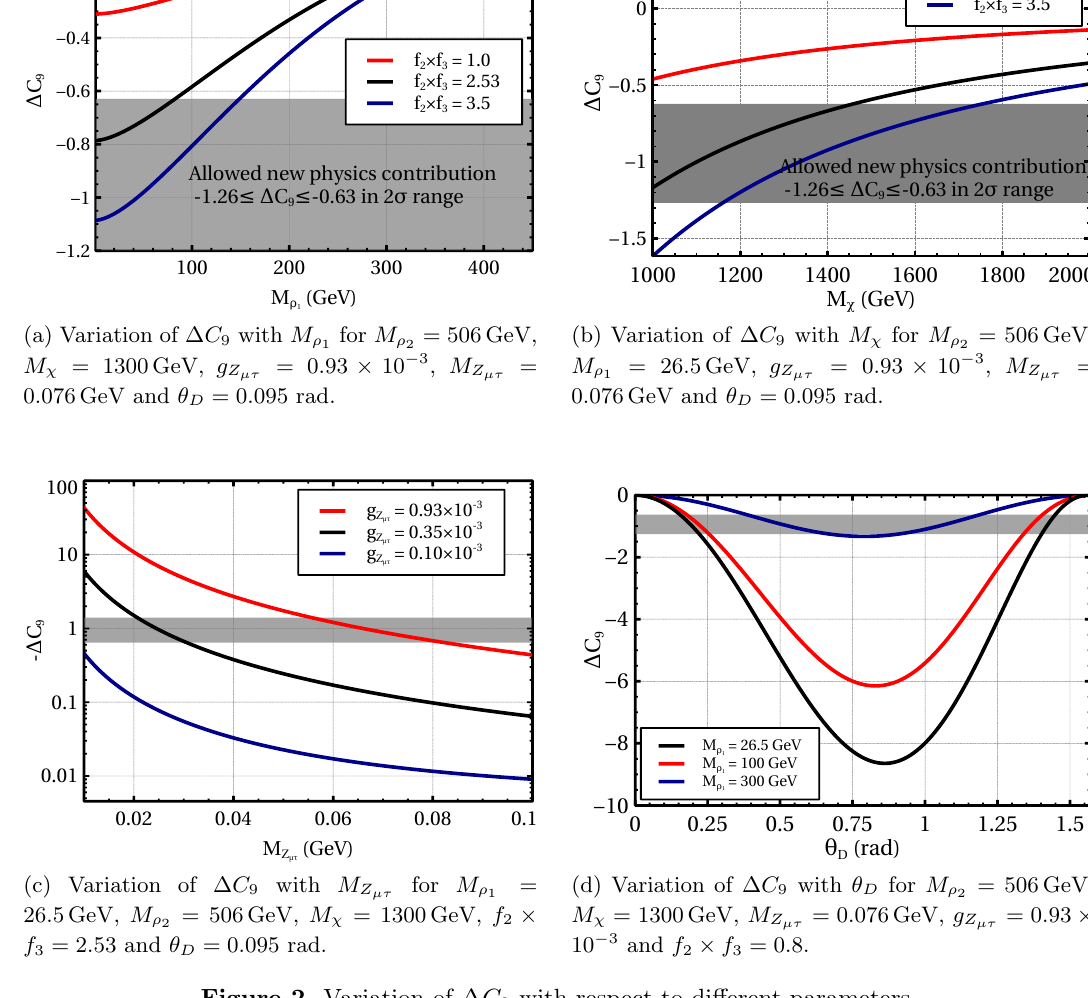
Figure 2 . Variation of (cid:1) C 9 with respect to di(cid:11)erent